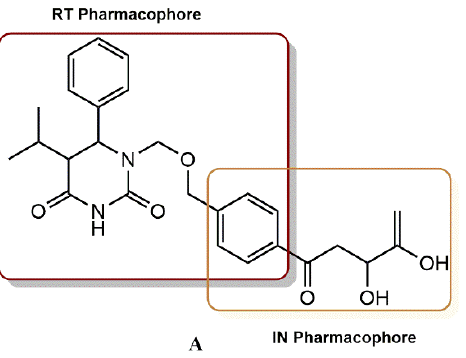
Figure 22. Rational design of RT/IN dual inhibitor featuring a HEPT and DKA pharmacophores for anti-RT activity and anti-IN activity, respectively.